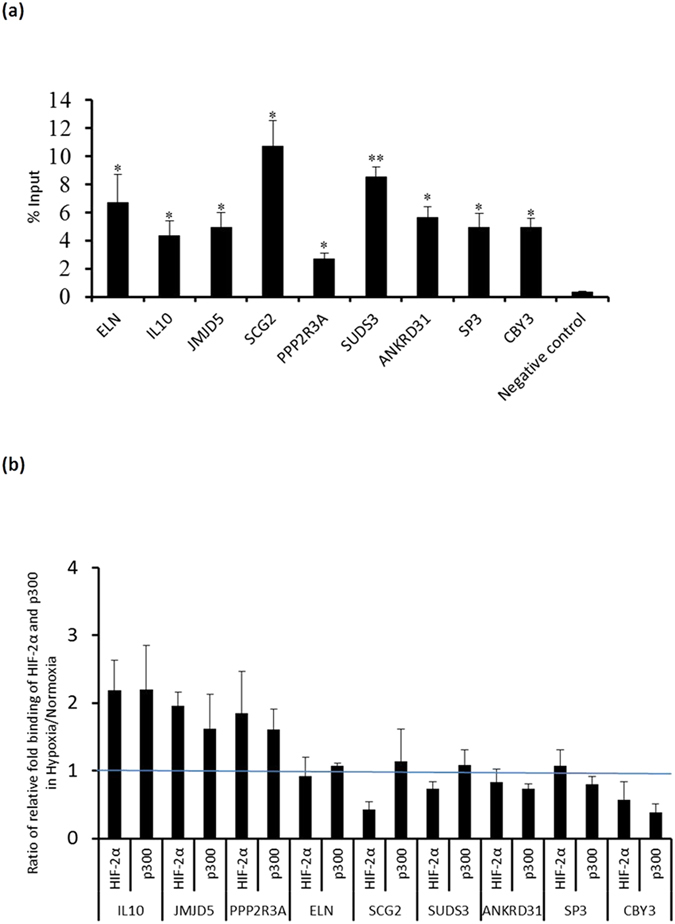
Chromatin enrichment of HIF-2α analyzed by using ChIP-PCR.(a) Representative enrichments of HIF-2α provided by ChIP-Seq analysis were further verified using semiquantitative PCR. Data are presented as signal relative to that of input DNA (100%). *P < 0.05 and **P < 0.01 vs. negative control. (b) The confirmed enrichments were further subjected to hypoxia mimetic treatment using CoCl2 (150 μM). Antibody against HIF-2α or P300 was used with the same primer pair. Signal of semiquantitative PCR relative to that of input DNA was used to calculate the relative fold binding between hypoxia and normoxia. All values were estimated by using image J (mean ± SD, n = 3).